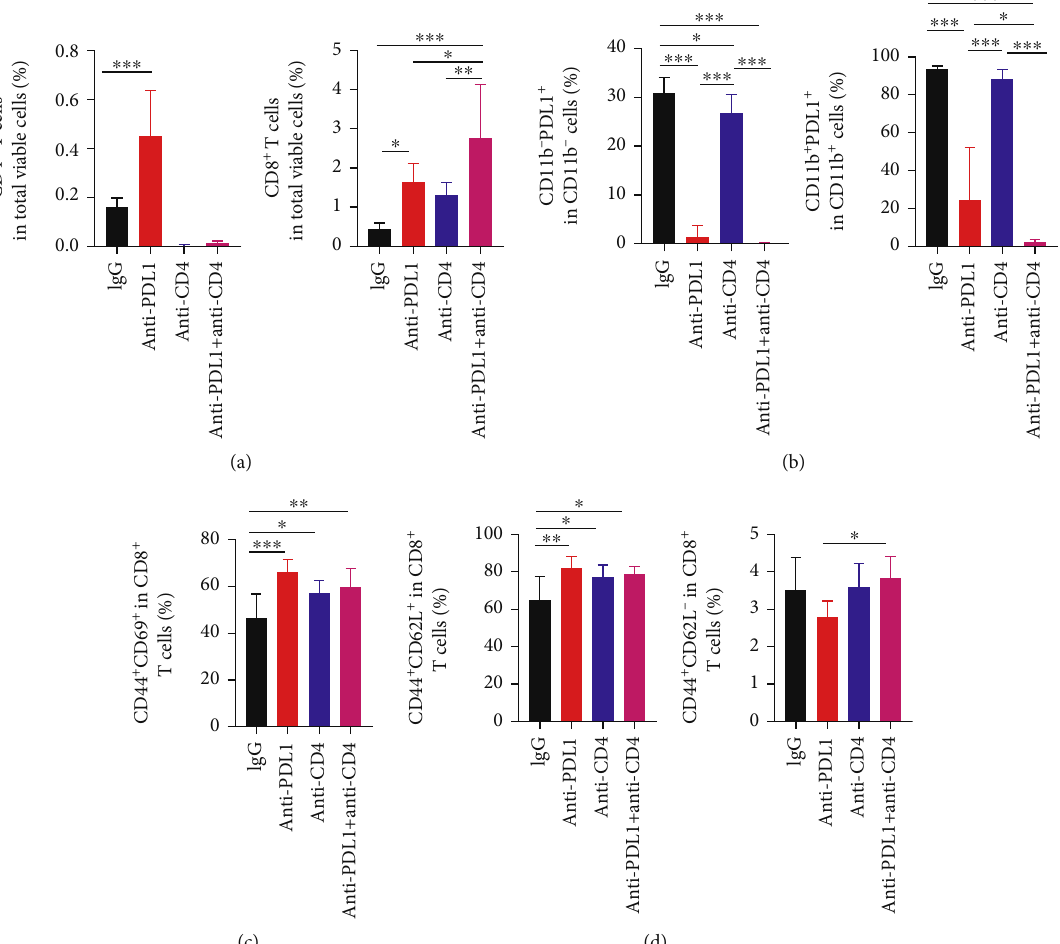
Figure 6: PD-L1 blockade and CD4 + T cell depletion additively promoted CD8 + T cell tumor in fi ltration and decreased the proportions of PD-L1 + immune cell populations within MCA38 tumors. MCA38 tumor-bearing mice were prepared and treated as described in Figure 5. On day 9 post anti-PD-L1 treatments, Mice were sacri fi ced and tumor tissues were harvested for fl ow cytometric analysis. (a) The percentages of intratumoral CD4 + and CD8 + T cells were assessed by fl ow cytometry. (b) The percentages of intratumoral PD- L1 + CD11b - and PD-L1 + CD11b + cells in lymphoid and myeloid cell populations, respectively. (c) The percentages of CD44 + CD69 + cells in the CD8 + T cell population. (d) The percentages of CD44 + CD62L + and CD44 + CD62L - cells in the CD8 + T cell population. Signi fi cant di ff erences were determined by one-way ANOVA. Data were from one experiment representative of two independent experiments with similar results ( n = 6 − 8 mice per group). Data were shown as means ± SD . ∗ P < 0 : 05 , ∗∗ P < 0 : 01 , ∗∗∗ P < 0 : 001